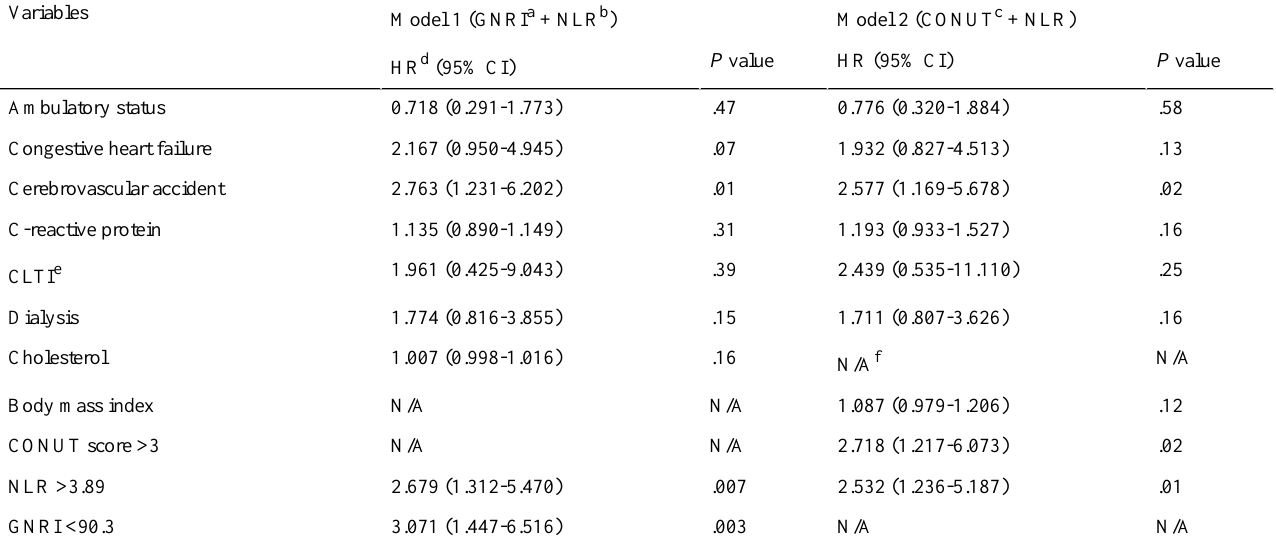
Table 3. Results of multivariate logistic regression analysis.